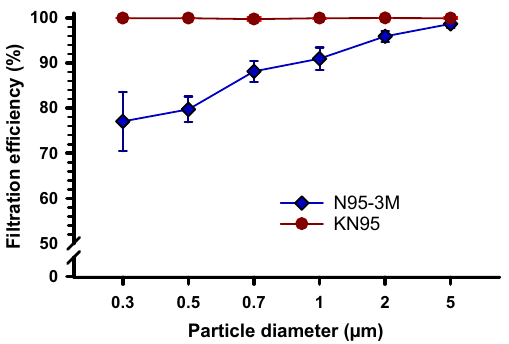
Figure 1. Filtration efficiency (FE) of KN95 and N95-3M FFRs. KN95 (n = 10) and N95-3M (n = 10) FFRs were applied to FE evaluation for different particle sizes (0.3–5 µm) using AeroTrak particle counter. Symbols represent the mean and error bars indicate the standard deviation. The overall FE of KN95 masks was significantly higher ( P = 0.022) than N95-3M masks. At each particle size, the KN95 masks’ FE was significantly higher ( P ≤ 0.001) than N95-3M